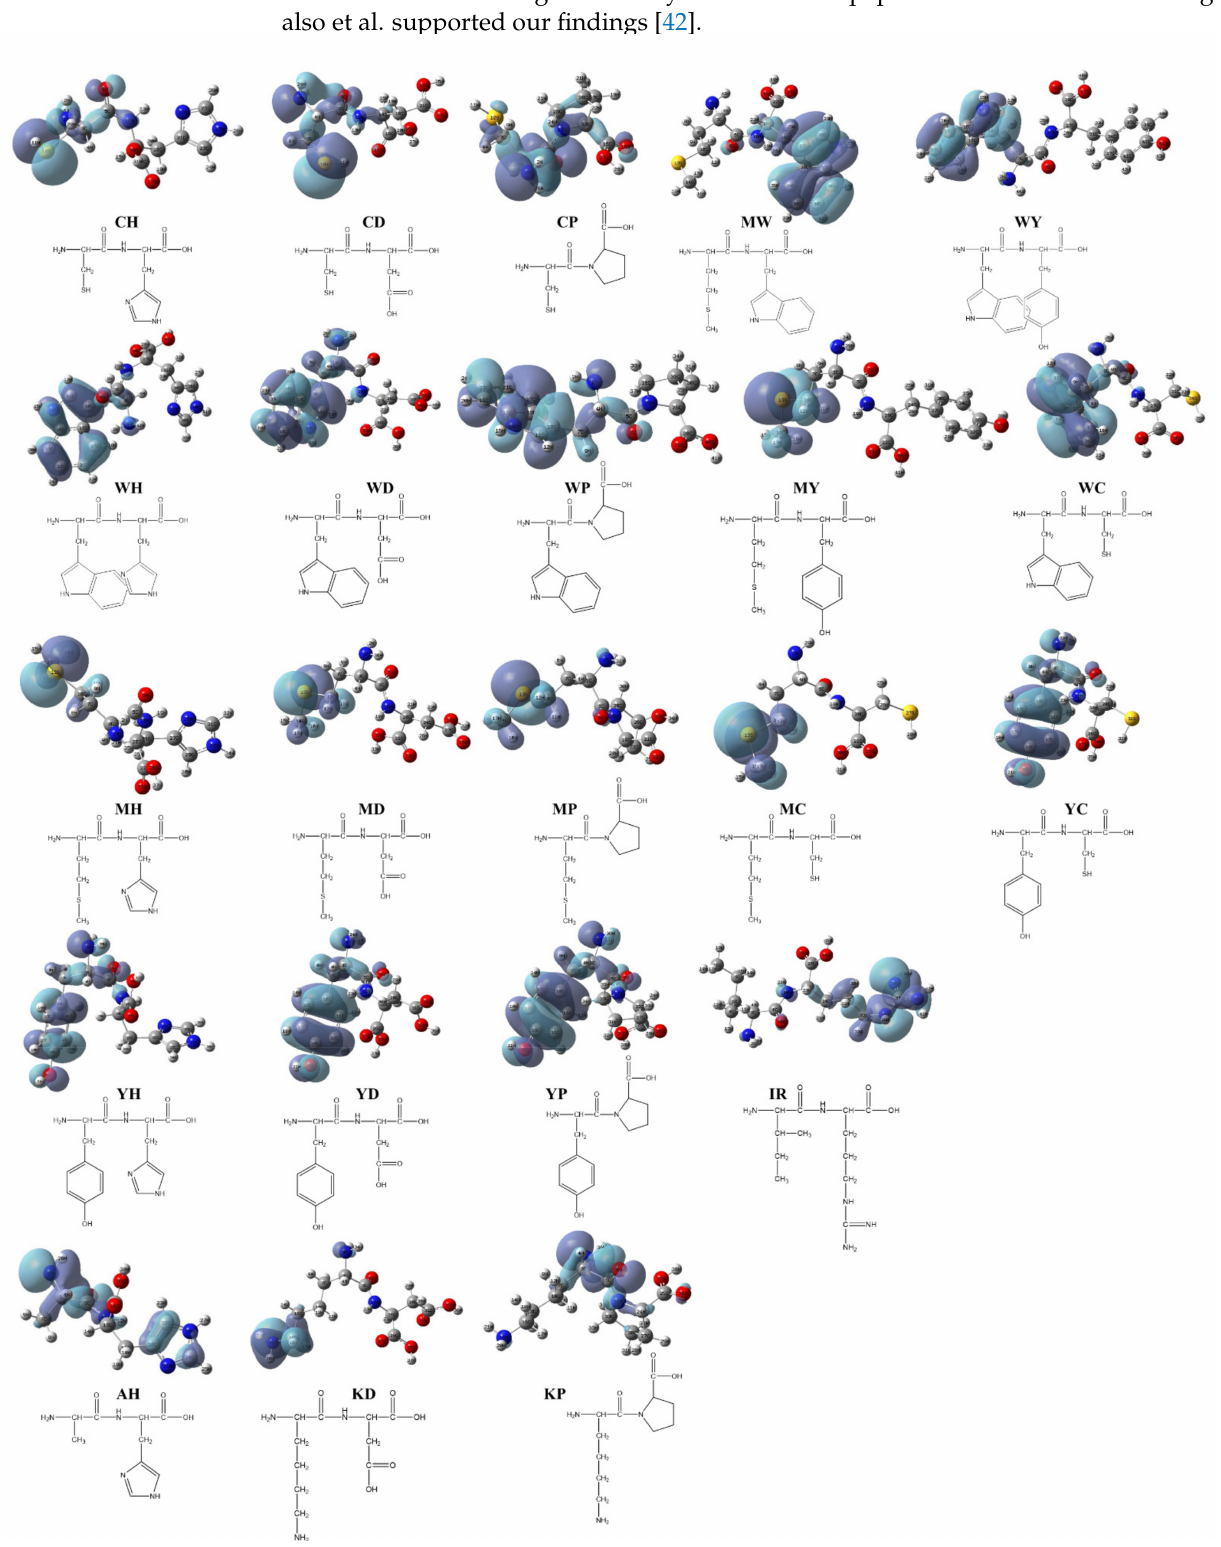
Figure 2. HOMO distribution of the dipeptides. Note: red ball represents the oxygen atom; blue ball represents the nitrogen atom; dark gray ball represents the carbon atom; yellow ball represents the sulfur atom; light gray ball represents the hydrogen